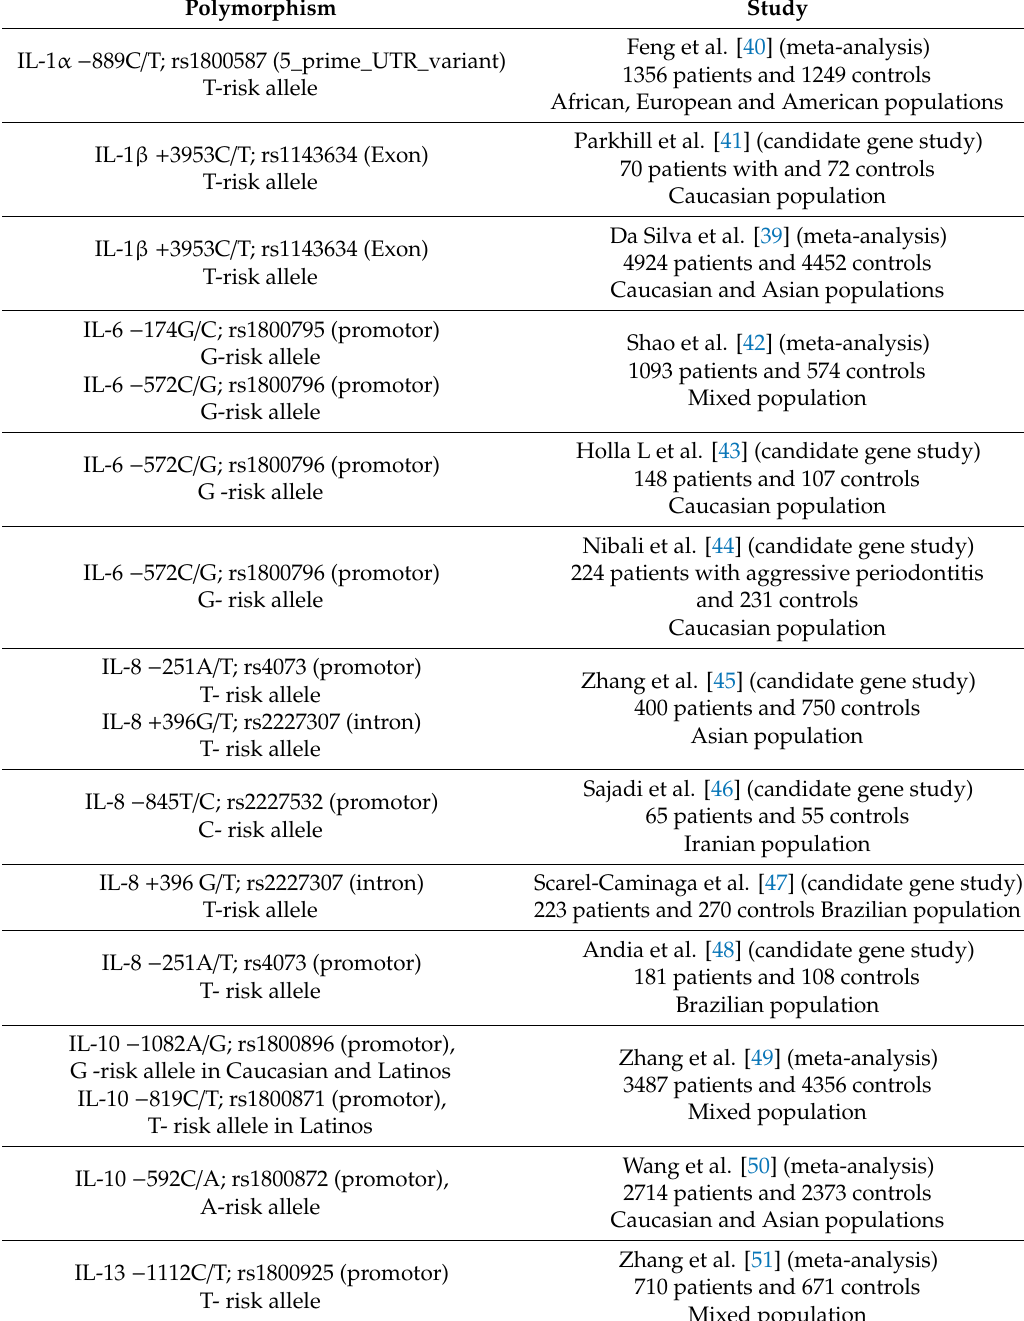
Table 1. Cytokine gene polymorphisms associated with periodontal